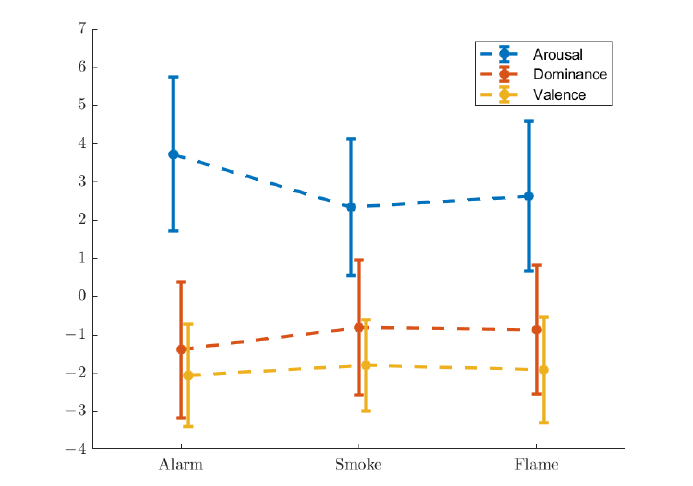
Figure 8. Shifts in SAM scores. Table 4. Mean values of SAM shifts.